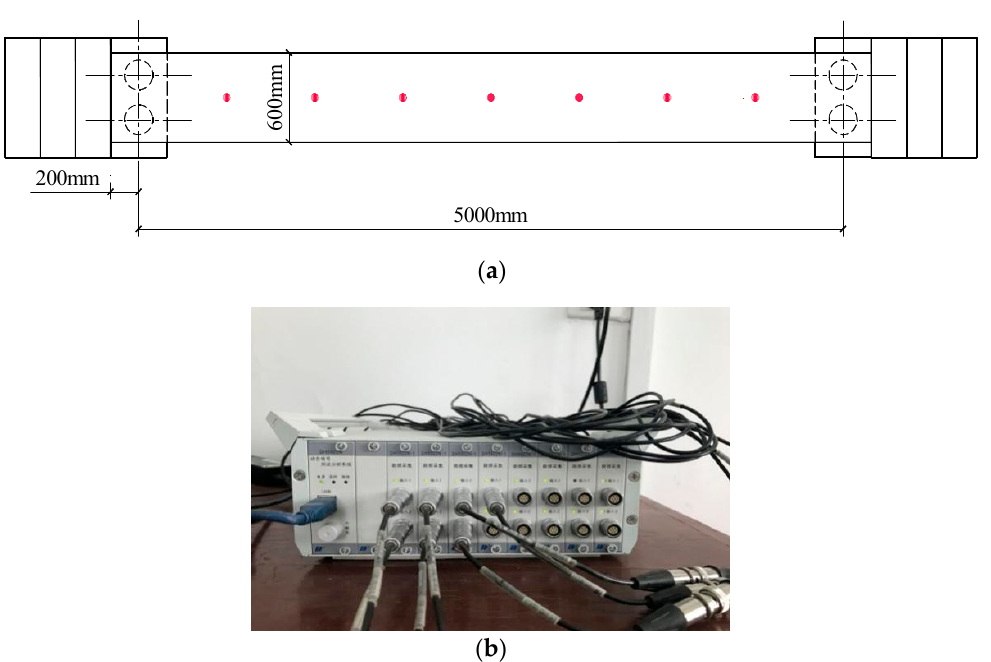
Figure 2. Locations of temperature measurement points. ( a ) Top surface. ( b ) Bottom surface.